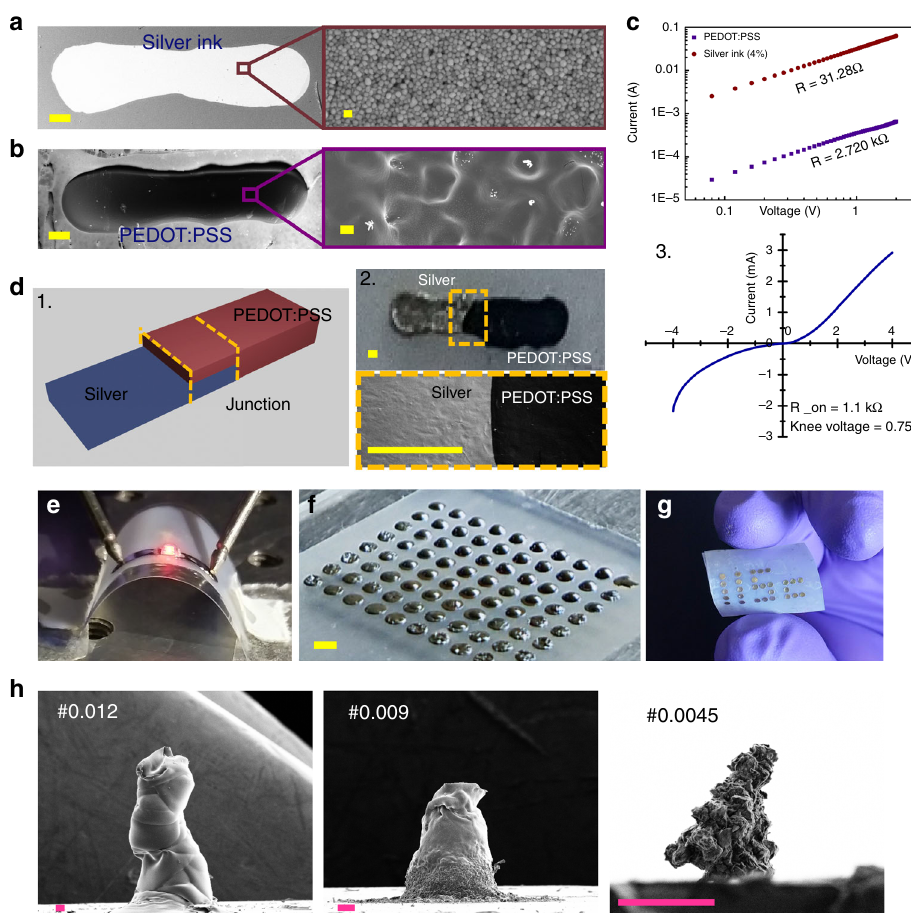
Fig. 5 Printing of electrically conducting materials for large-area fabrication and fl exible electronics applications. Room-temperature printing of ( a ) silver ink (4% (v/v)) conductive line (scale bar: 200 µ m) and the corresponding scanning electron microscopy (SEM) image (scale bar: 100 nm). b PEDOT: PSS-printed line (scale bar: 200 µ m) and the corresponding SEM image showing the connectivity (scale bar: 20 µ m). c IV characteristics of both silver and PEDOT:PSS-conducting lines. d (1) Silver ink and PEDOT:PSS were further used to form a junction to show the capability of the technique for electronic applications. (2) Optical microscopic and the SEM image showing the junction (scale bar: 250 µ m). (3) In addition, IV characteristic was performed for the junction to check the connectivity. Further, as a demonstration ( e ) two silver-conducting lines are connected using drop- impact printing technique, and the voltage is applied at both ends to show the glowing LED. f Large-area droplet patterning (scale bar: 1 mm), g fl exible printing, and h 3D pillars printed using sieves with different pore openings have been shown to demonstrate the wide applicability of this technique (scale bar: 100 µ (Fig. 5f and Supplementary Movie 7), printing of letters on a fl exible substrate (Fig. 5g), and 3D-printed ZrO 2 pillars using sieves with different pore openings (Fig. 5h), are presented. Supplementary Movie 8 shows drop-by-drop printing of a micropillar using sieve #0.012. In addition, we demonstrate the possibility of scaling the printing process through multiple drop impacts on a single sieve #0.009 (Supplementary Movie 9). The main advantage of drop- impact printing is easy handling and cost-effective large-area printing (Fig. 5f and Supplementary Fig. 16).